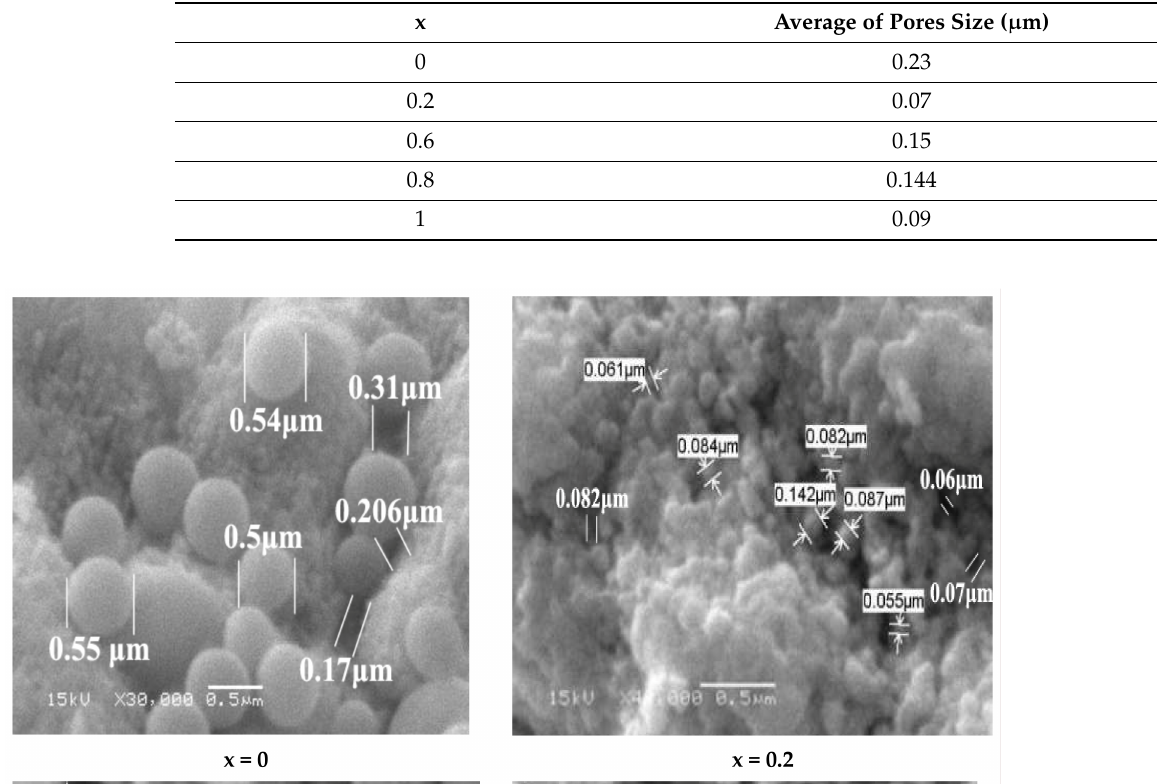
Mg + 2 Fe + 3 O 4 (x = 0, 0.2, 0.6, 0.8, and 1). x 2 1 − x